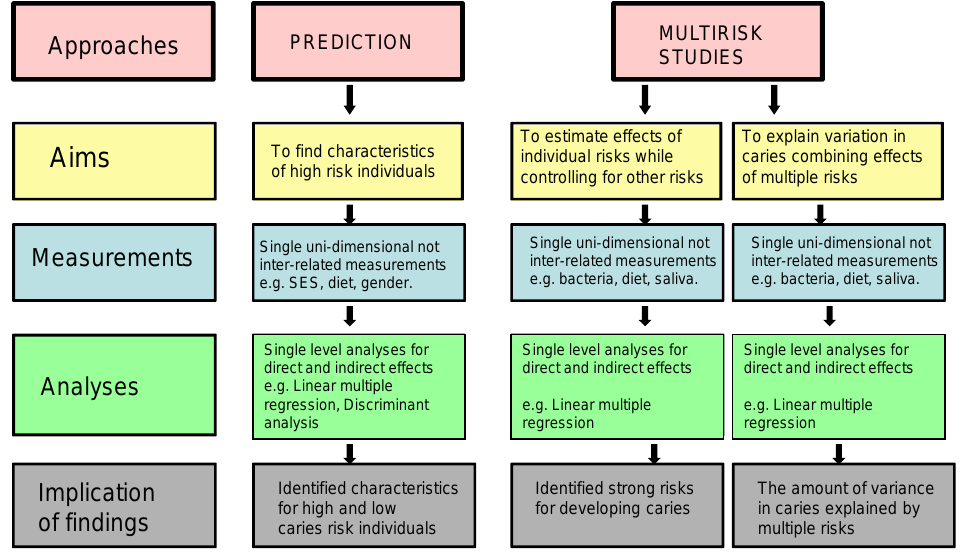
Figure 1. Current status of common caries risk